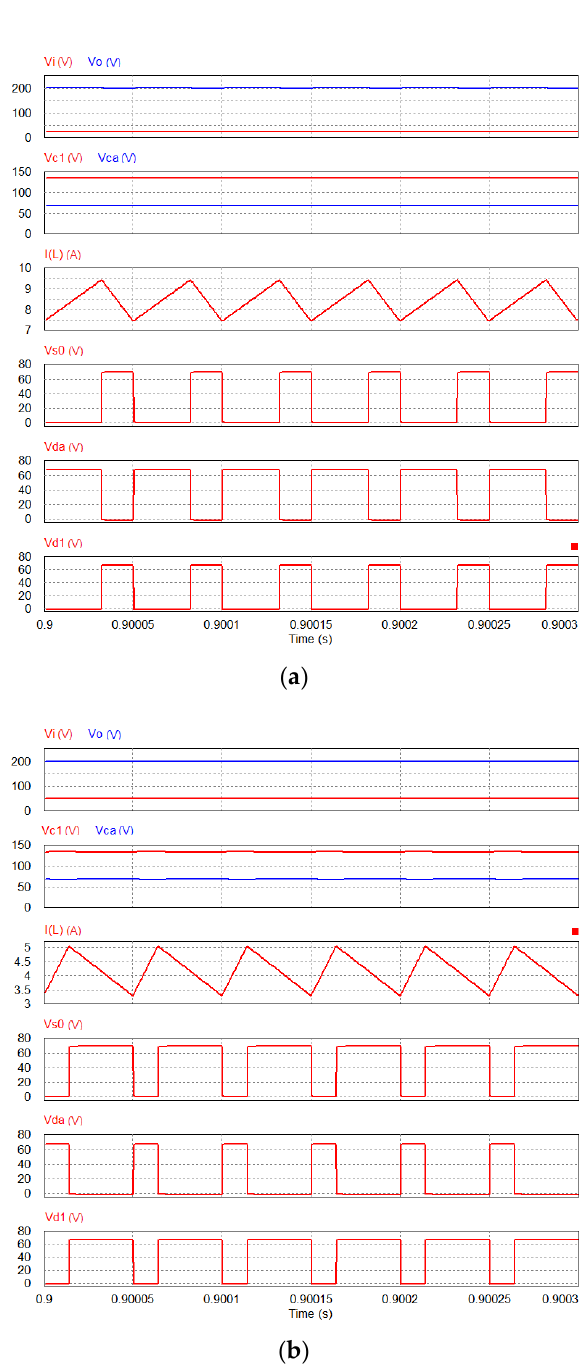
Figure 9. Simulation waveforms when ( a ) V i = 25 V and ( b ) V i = 50 V. Waveforms: input voltage, output voltage, capacitor C 1 , C 2 , C 3 , C a and C b voltages, input current, drain-source voltage of S 0 , and diode D a and D 1 voltages.